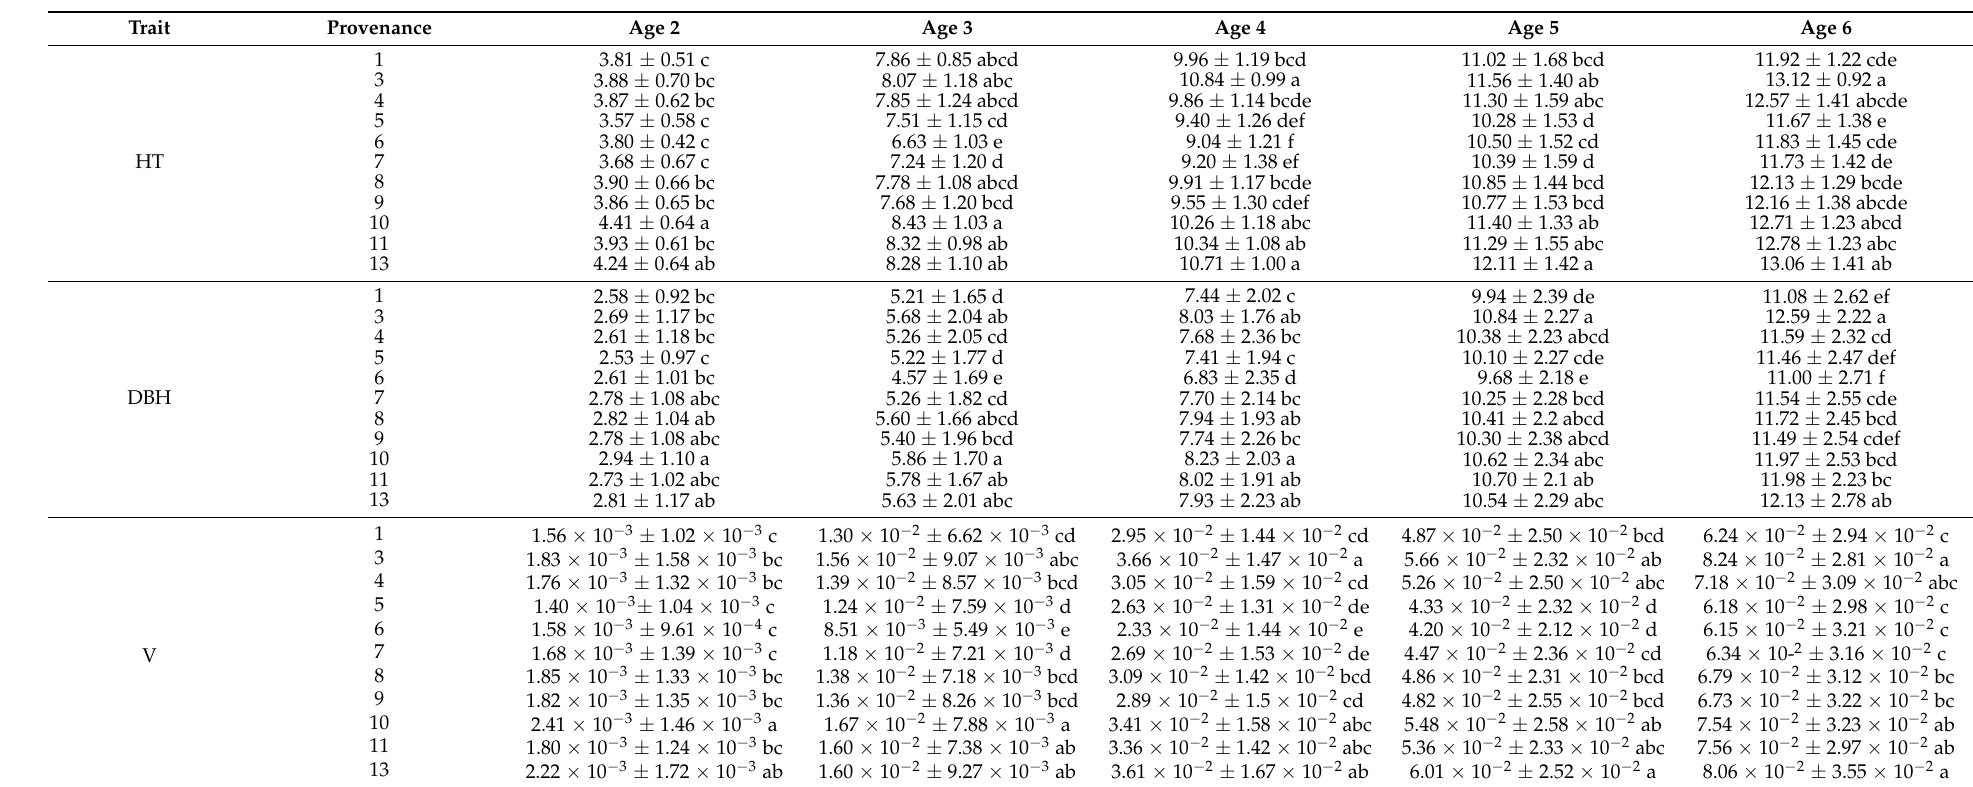
Table A1. Statistics of growth traits for all provenances at different forest